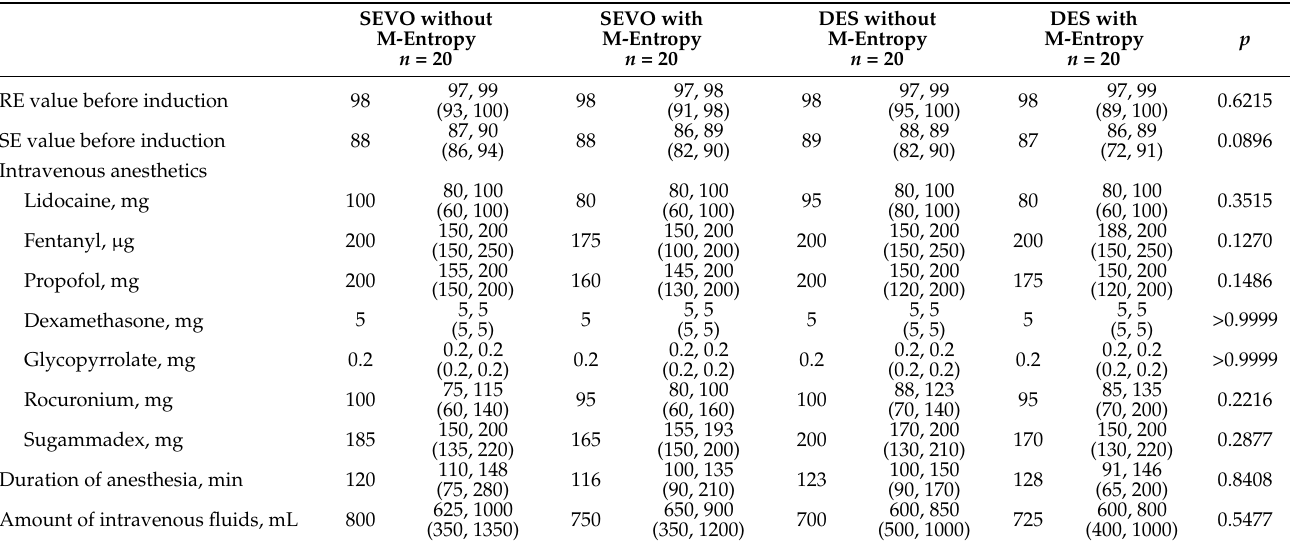
Table 2. Baseline entropy values and intraoperative anesthetic